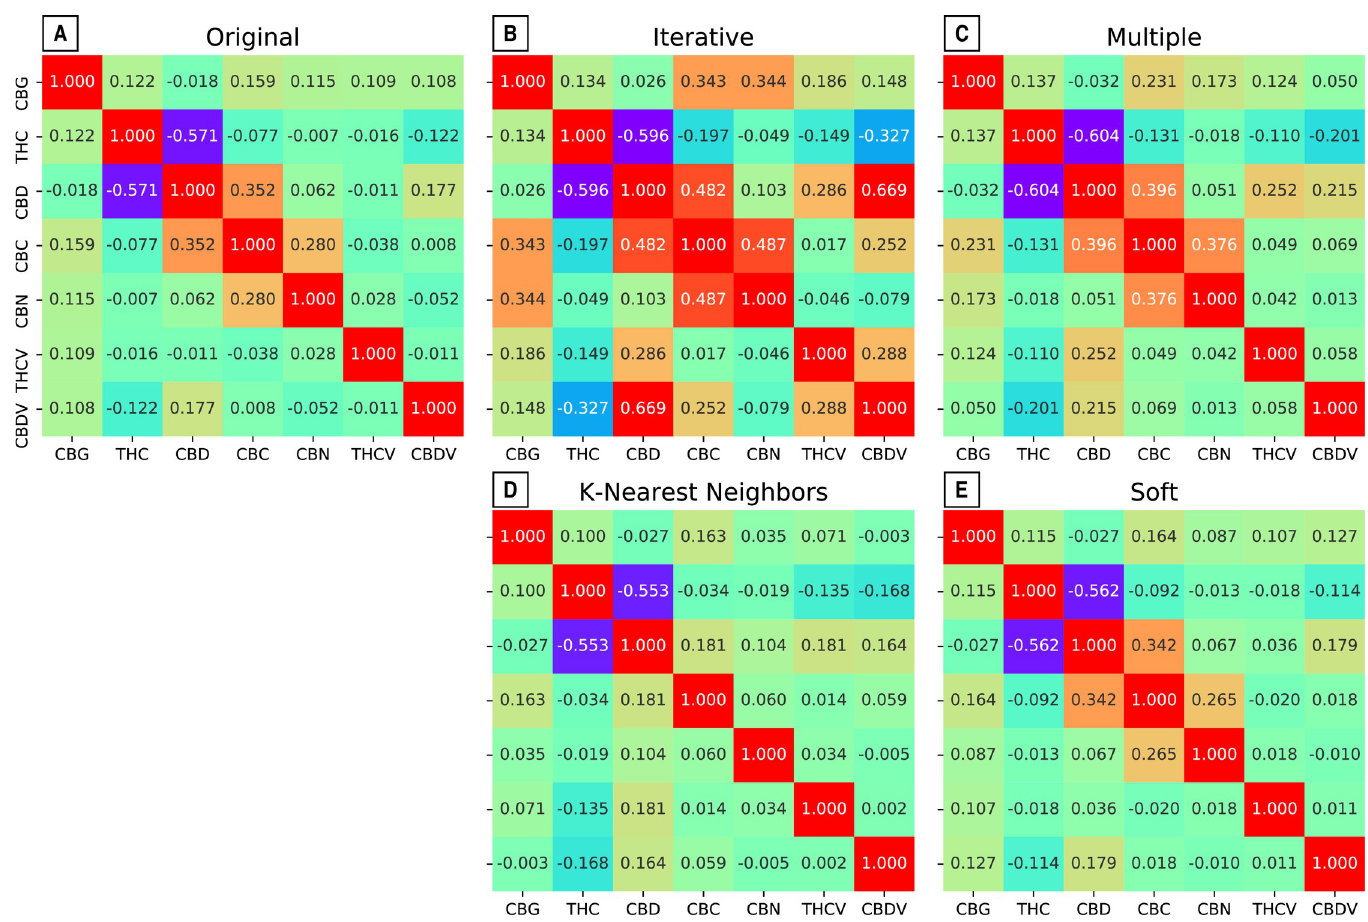
Fig 4. Heatmap of the symmetric pairwise Pearson correlations. Correlations were performed across the original data and the data from the four imputation methods.